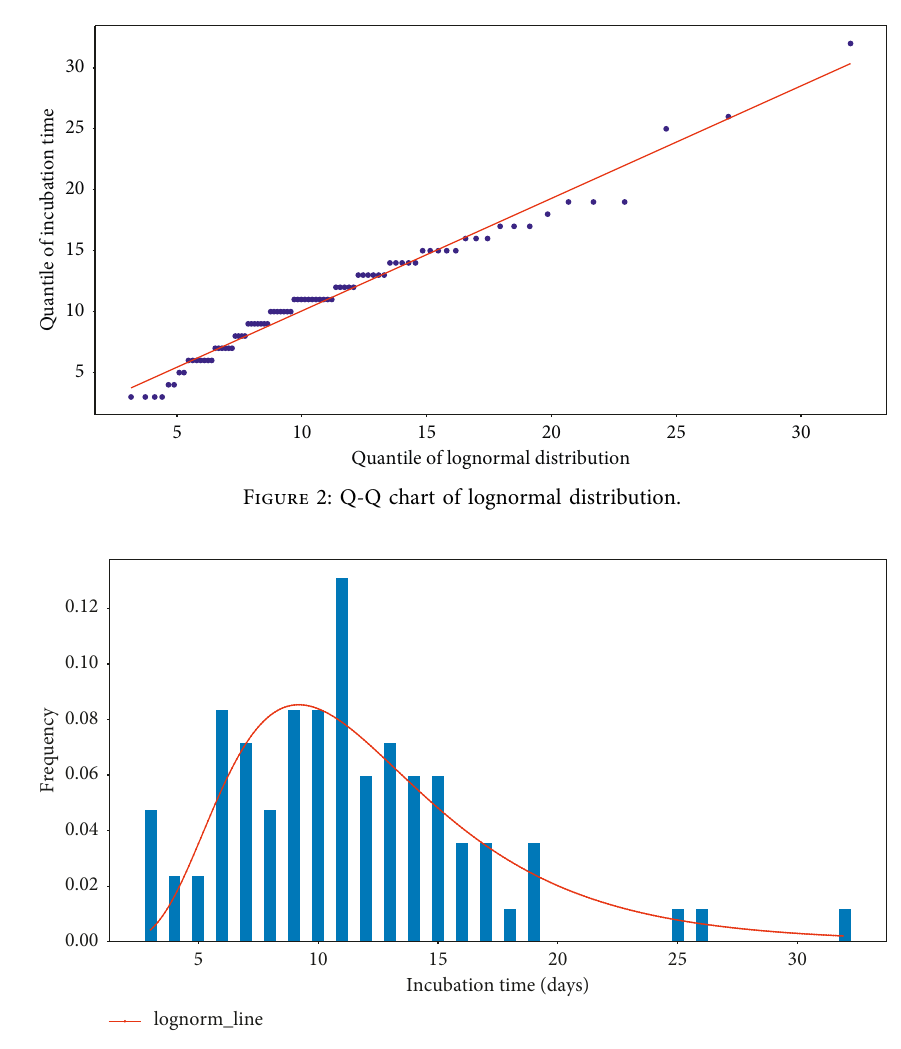
Figure 3: Frequency histogram of incubation time and fitting curve of lognormal distribution. Table 2: Outliers